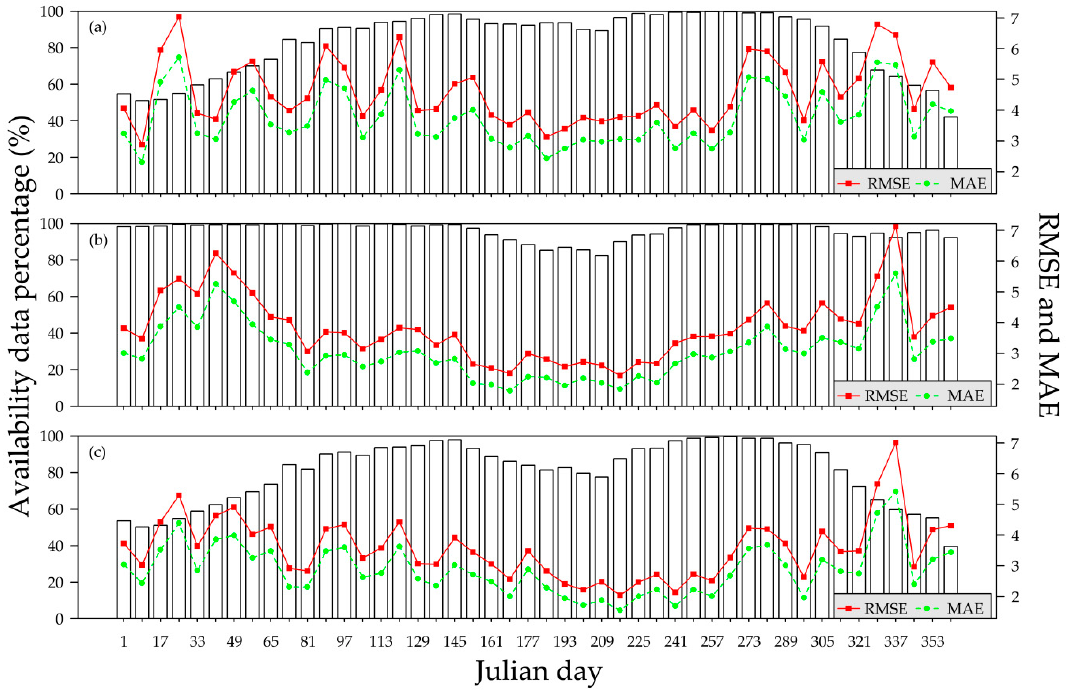
Figure 8. Relations between the temporal distribution of data availability and model performance, ( a ) T max , ( b ) T min , and ( c ) T mean . Data availability is the percentage (%) of the valid data used in model calibration/validation.